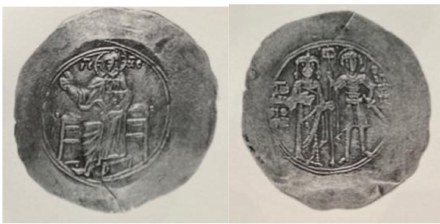
Figure 8. Aspron Trachy Nomisma, 1118–1143; impression on electrum; Dumbarton Oaks, Washing- ton D.C.; 8e.1 Peirce 1948 (H. Pl. 10.5). Published at [15] (Ibid, pp. 261–274. The issues from the mint at Thessalonike have St Demetrios, the patron saint of the city, while those from Constantinople have St George. Images on Plates VIII and IX).